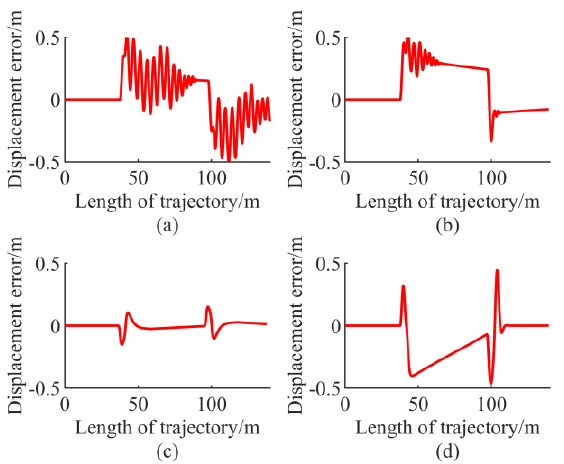
Figure 24. The displacement error when parameters changed. ( a ) LMPC. ( b ) LEMPC. ( c ) NMPC. ( d ) NEMPC.